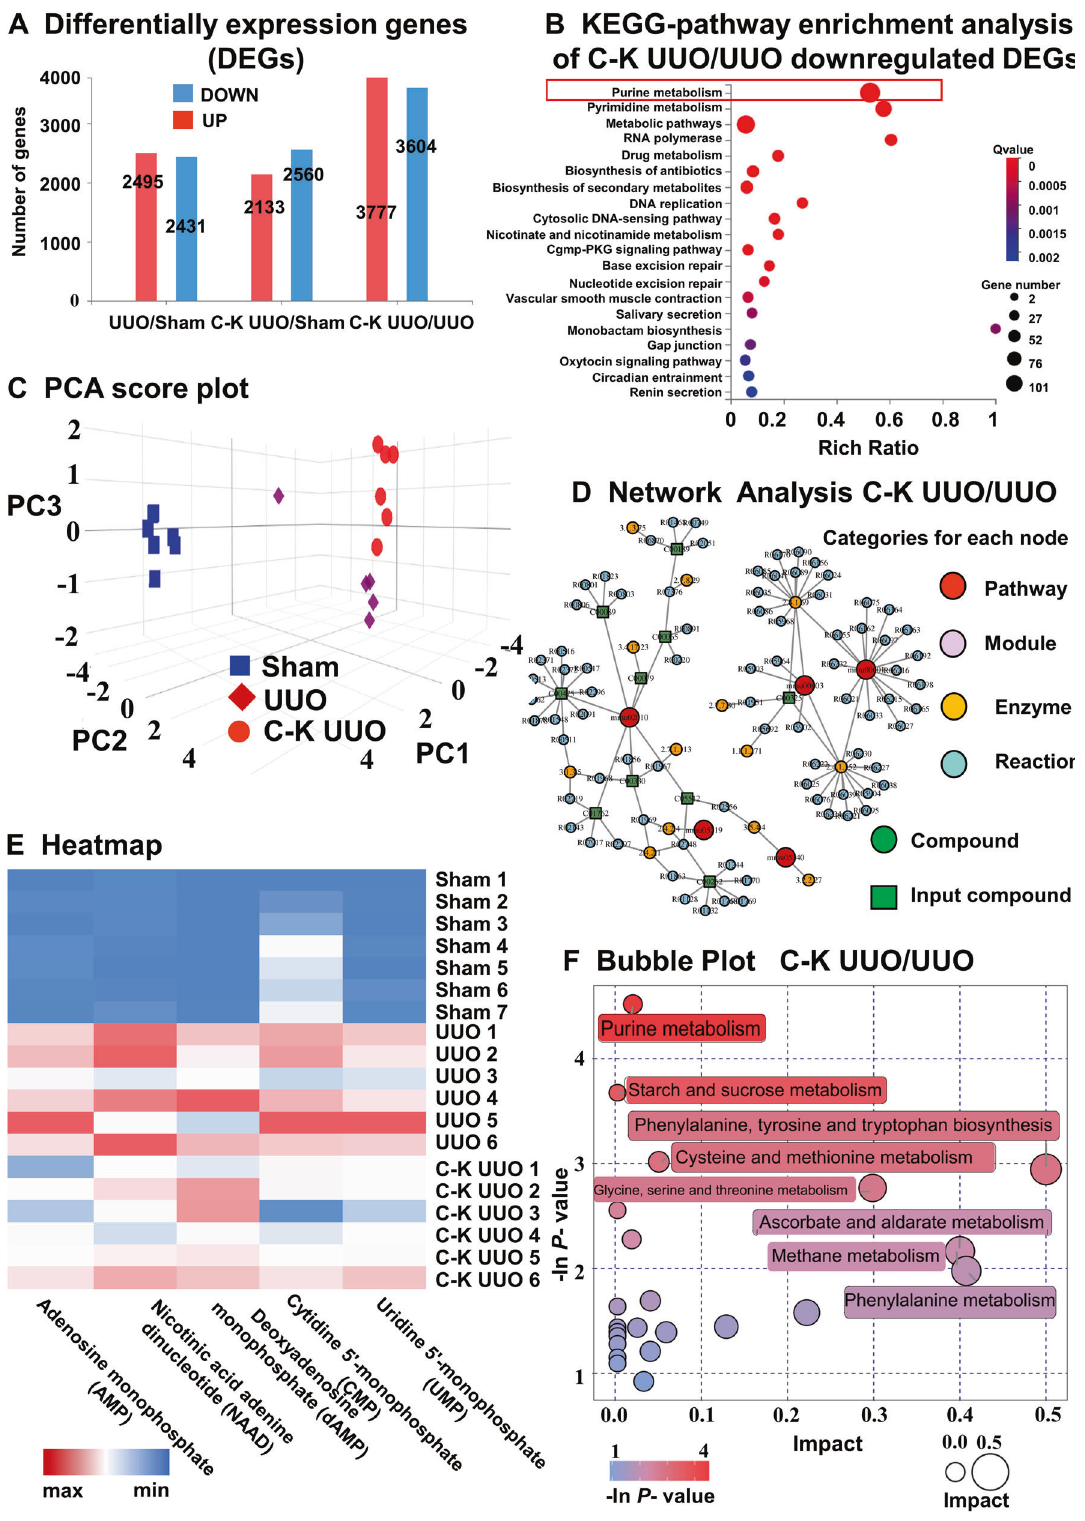
Fig. 4 Transcriptomics and Metabolomics of C-K UUO mice revealed that knockout of Cx43 gene mainly affects the accumulation of purine substances in TECs. A Differentially expression genes. B KEGG-pathway enrichment analysis of C-K UUO/UUO downregulated DEGs. C Principal component analysis (PCA) score plot. D Network analysis of differential products between C-K UUO and UUO group. E Heatmap of selected enriched terms (FDR ≤ 0.01) from KEGG-pathway analysis of downregulated DEGs in C-K UUO group and upregulated DEGs in UUO group. F The bubble plot shows that the main difference between UUO and C-KUUO group is purine metabolites.